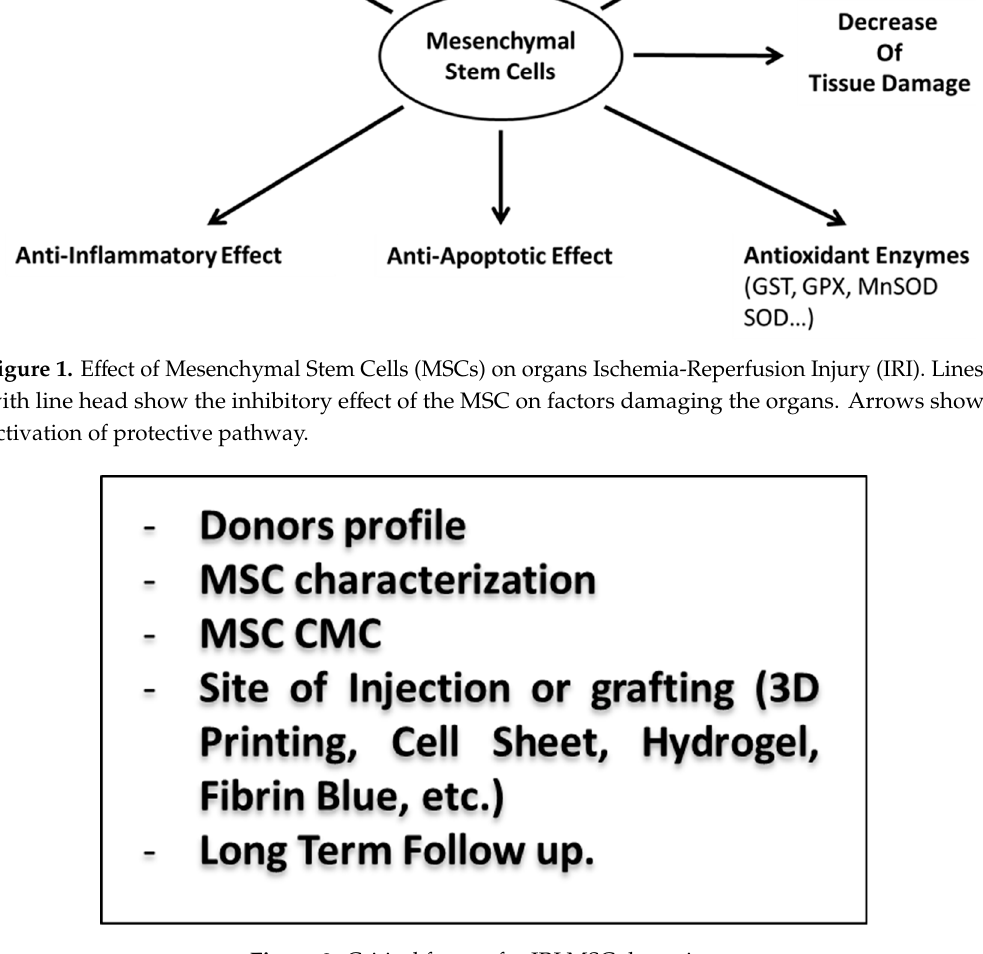
Figure 2. Critical factors for IRI MSC therapies.